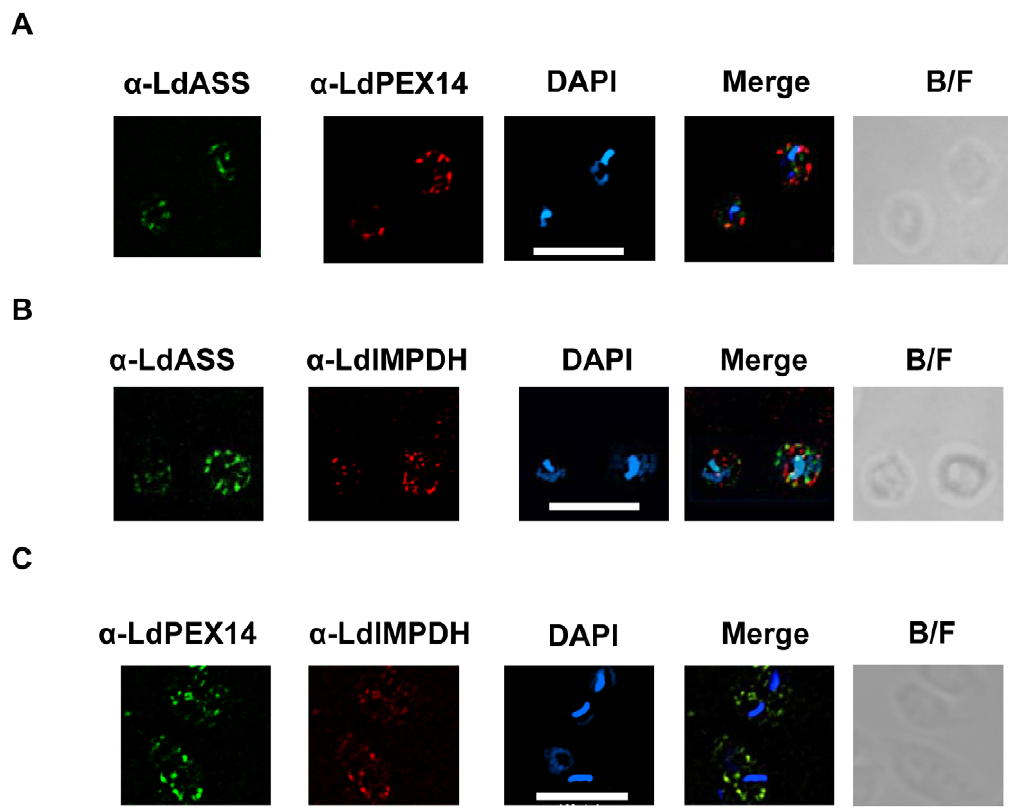
Figure 5. Comparison of LdASS localization with LdPEX14 and LdIMPDH. (A) L. donovani amastigotes were stained with antibodies against LdPEX14 and biotinylated anti-LdASS antibodies as primary, then with Alexa568 (red)-conjugated anti-rabbit IgG and Streptavidivin FITC as secondary. The nucleus and kinetoplast were stained with DAPI. (B) L. donovani amastigotes were stained with antibodies against affinity purified LdASS and guinea pig anti-LdIMPDH antibodies as primary, then with Alexa488 (red)-conjugated anti-rabbit IgG and Alexa564 (red)-conjugated anti- Guinea-pig IgG as secondary. The nucleus and kinetoplast were stained with DAPI. (C) L. donovani amastigotes were stained with rabbit anti-LdPEX14 and Guinea pig anti- LdIMPDH as primary, and Alexa488 (green)-conjugated anti-rabbit IgG and Alexa568 (red)-conjugated anti-guinea pig IgG as secondary antibodies. The nucleus and kinetoplast were stained with DAPI. The merge of the images is shown in the column labeled ‘‘Merge’’. The right panel shows the bright field images. The white bar represents the scale that corresponds to 10 m m.